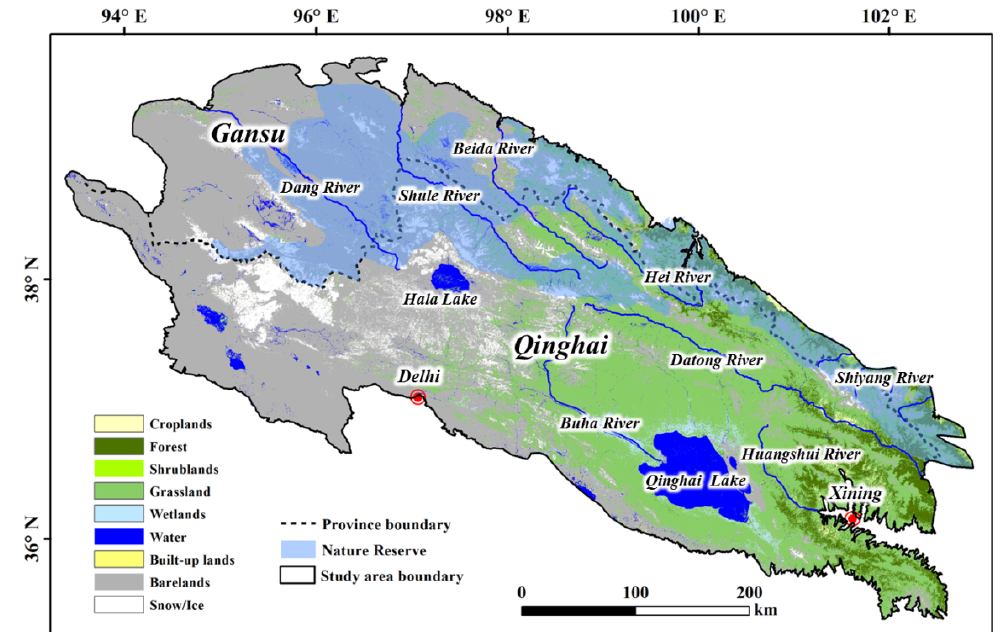
Figure 2. Land use/cover in the QLM.